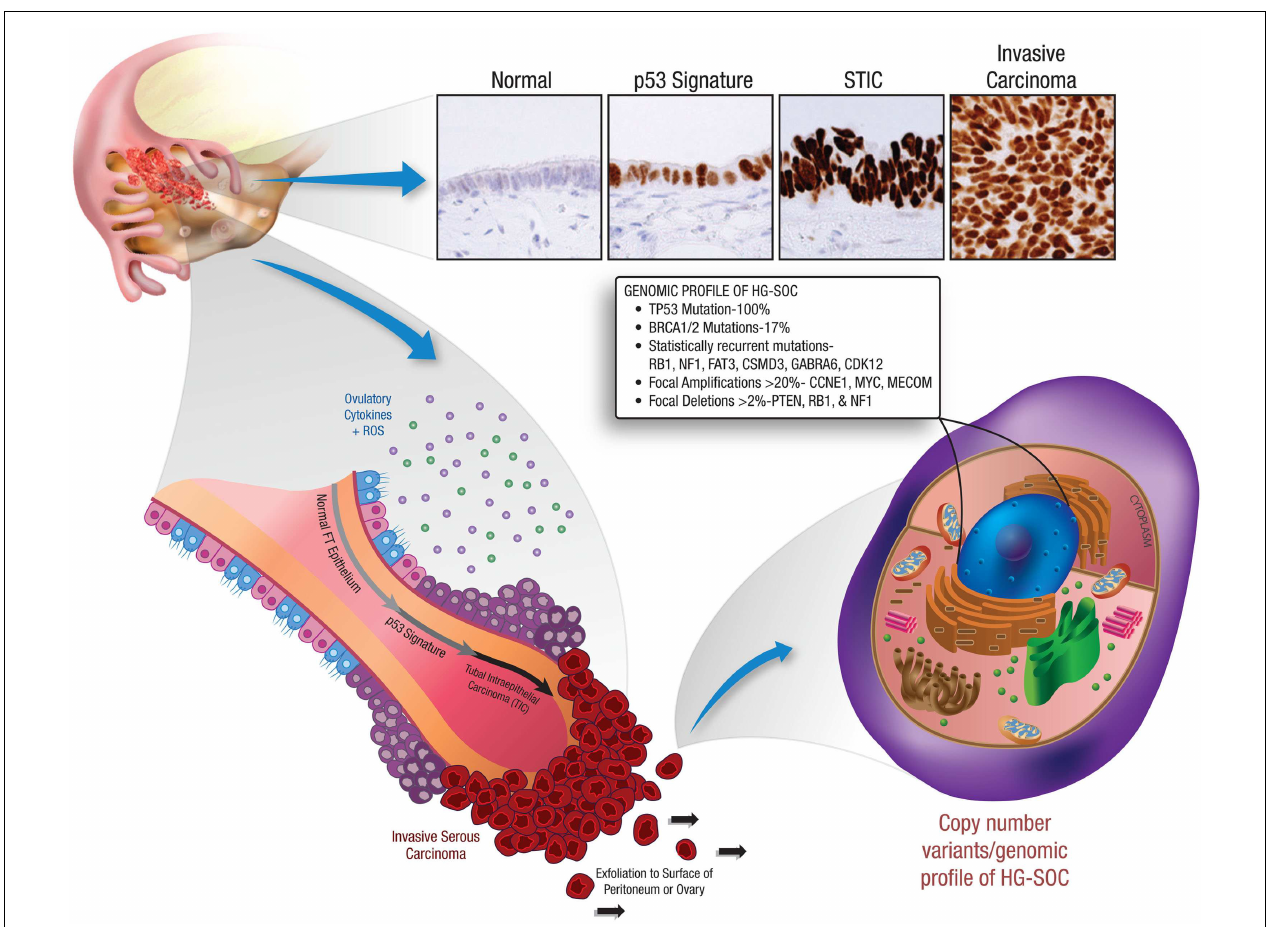
development of serous tubal intraepithelial carcinoma (STIC). Breaching of the basement membrane and localized dissemination to the ovary and/or peritoneal cavity heralds the development of invasive HG-SOC and the associated clinical scenario. HG-SOCs that involve the ovary or peritoneum are characterized by mutations in TP53 (and BRCA1 in familial cases) and display a complex genomic terrain with widespread copy number alterations throughout the